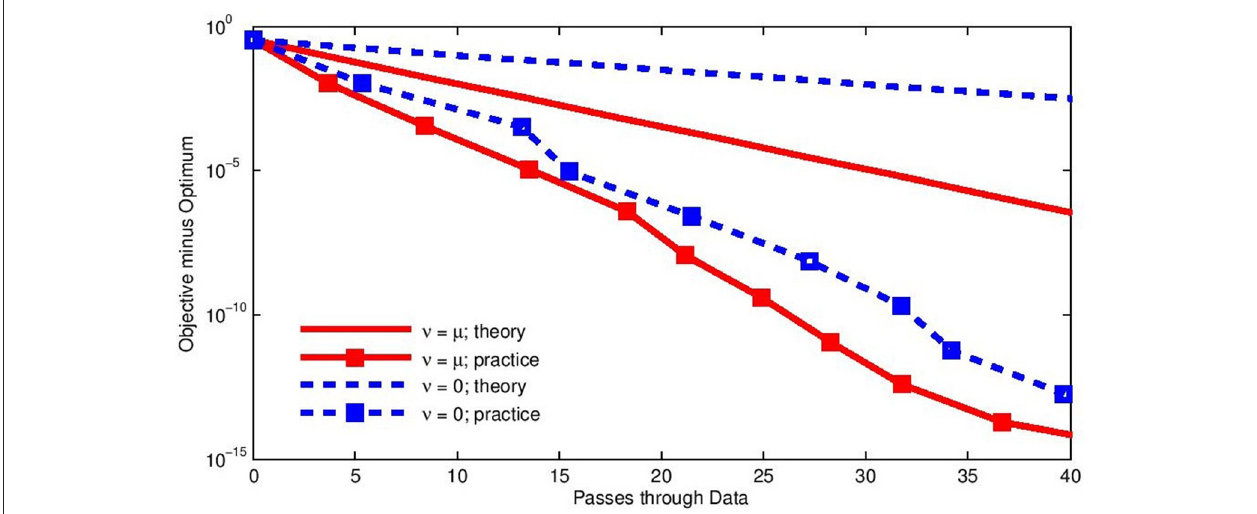
µ (full red line) and ν 0 (dashed blue = =